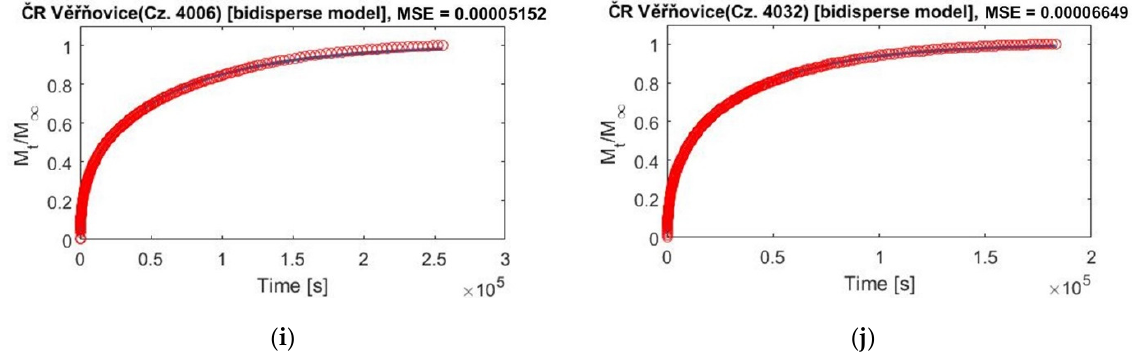
Figure 5. Fitting of the bidisperse model runs with experimental sorption data: ( a ) Sobieski (D-25); ( b ) Sobieski (D-24); ( c ) Piast (D-34); ( d ) Mys ł owice-Weso ł a (D-37); ( e ) Borynia (D-6); ( f ) Zofiówka (D-22); ( g ) Pniówek (D-7); ( h ) Zofiówka (D-23); ( i ) Č R-V ěřň ovice (Cz. 4006); ( j ) Č R-V ěřň ovice (Cz. 4032). Table 3. The unipore diffusion model fitting parameters for the methane adsorption rate data at pressure 0.1